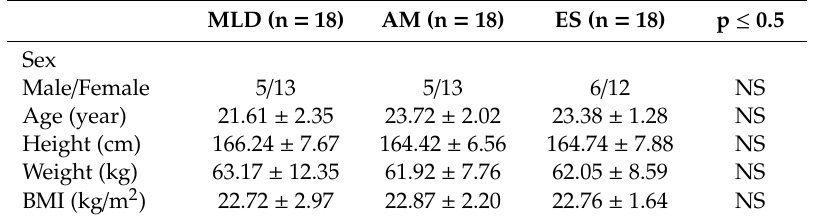
Table 2. General characteristics of subjects (n =